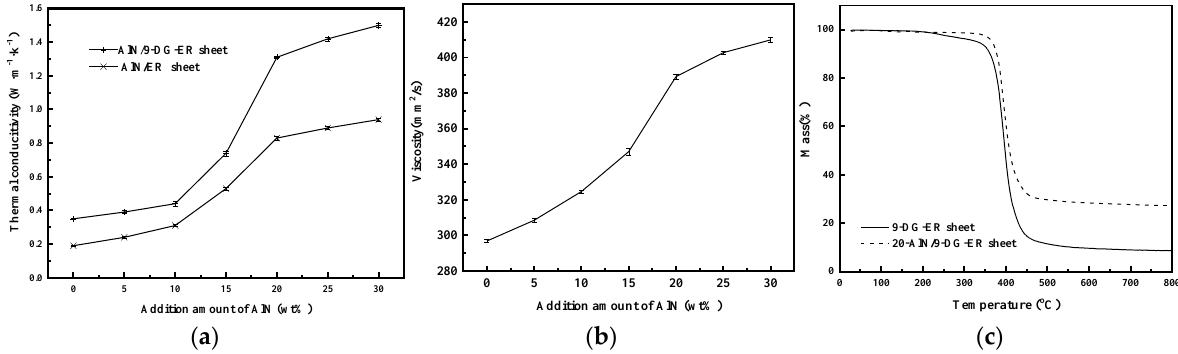
Figure 6. ( a ) The thermal conductivity of the AlN/DG-ER and AlN/ER sheets; ( b ) the viscosity curve of the AlN/DG-ER paint and ( c ) the TGA curves of the 20-AlN/DG-ER and 9-DG-ER sheets.